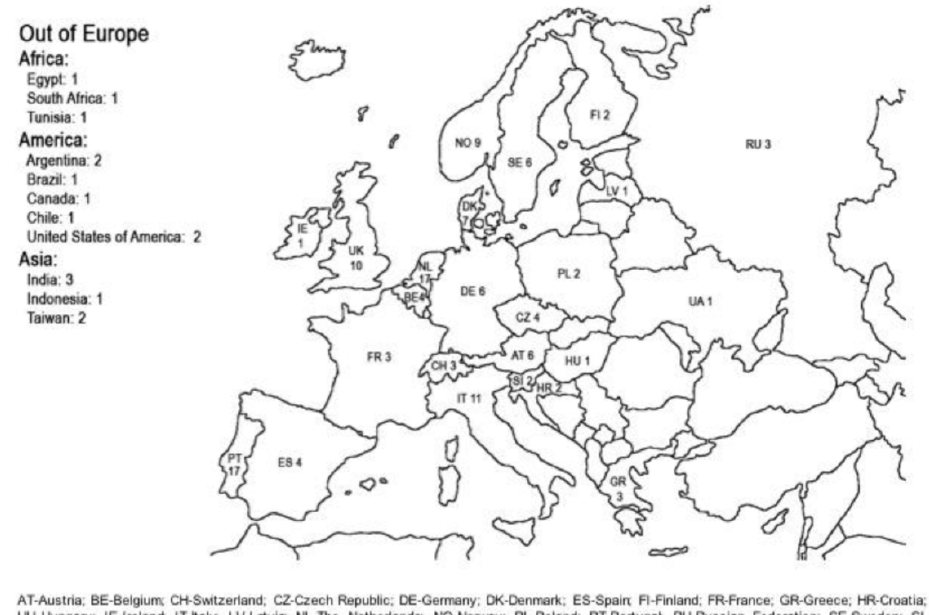
Figure 1. Geographical distribution of